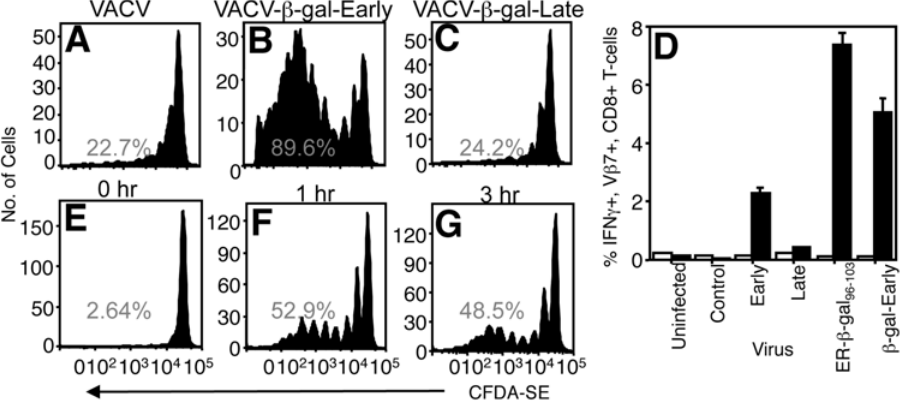
Figure 4. Late VACV promoter-driven antigen is not available for cross presentation. Proliferation (A–C) of adoptively transferred b -gal- specific TCR transgenic T CD8 + was measured following immunization with TAg- b 2 m neg cells infected with VACV that does not express b -gal (A), rVACV- b -gal-Early (B), or rVACV- b -gal-Late (C) for 5 h. (D) b -gal 96–103 -specific IFN- c production by adoptively transferred BG1 T CD8 + was measured following immunization with TAg- b 2 m neg cells infected for 5 h with VACV as shown. IFN- c production is shown in the presence (black bars) or absence (open bars) of b -gal 96–103 peptide. (E–G) TAg- b 2 m neg cells were infected with rVACV- b -gal-Early for 0 h (E), 1 h (F), or 3 h (G) and assayed for their ability to initiate proliferation of adoptively transferred b -gal-specific TCR transgenic T CD8 + .